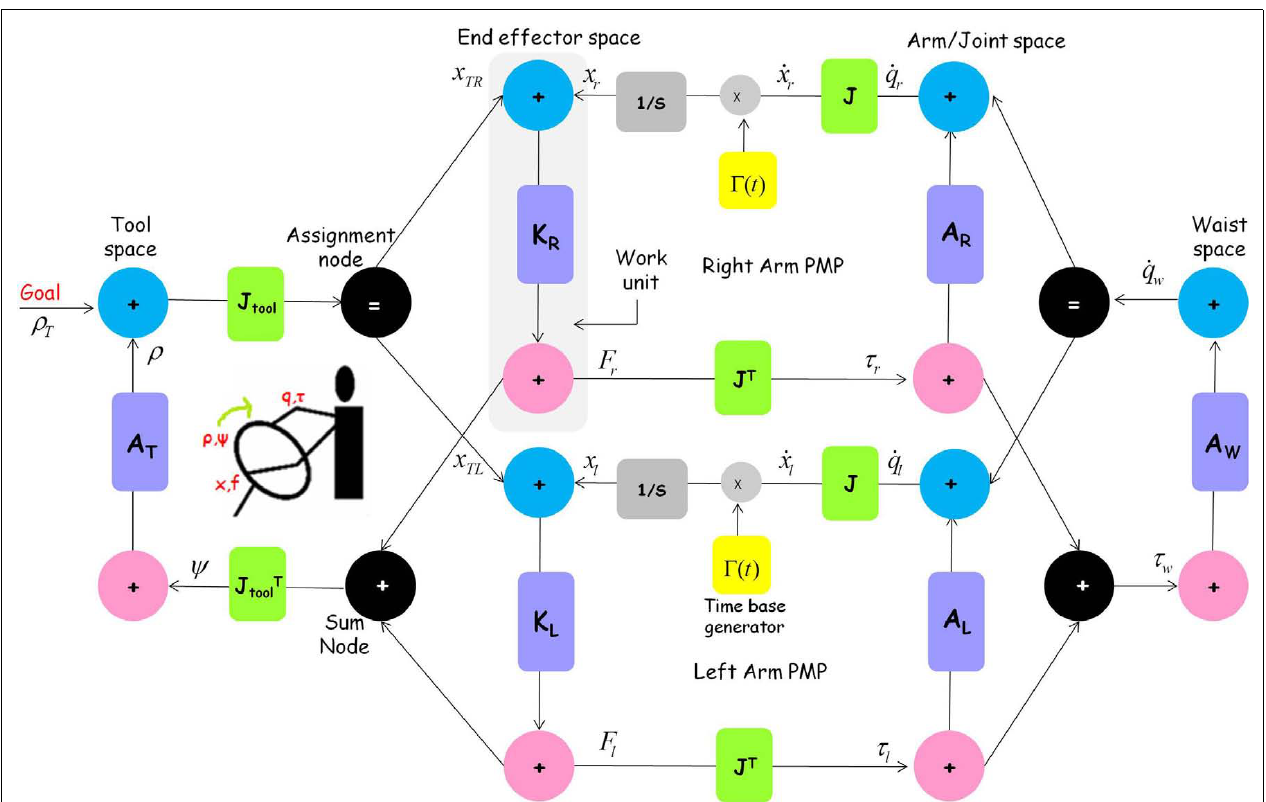
or assign (forces or displacements) between different motor spaces. Also note that the resulting network is fully connected, connectivity articulated in a fashion that all transformations are “well posed.” Intuitively, as the goal pulls the tool tip, the end-effectors are being simultaneously pulled to respective positions so as to allow the tool to reach the goal. At the same time, the joints (in the two arms and waist) are being pulled to values that allow the two hands to reach positions that allow the tool to reach the goal.This process of incremental updating of every node in the network continues till the time the tool tip reaches the goal (and equivalently the force field in the network is 0). Also note that all computations are local in the sense that every element responds to the pull of the goal based on its own impedance and all these local contributions sum up to create the global synergy achieved by the